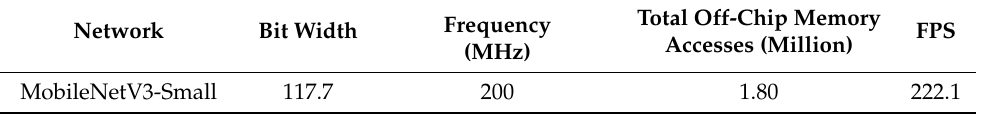
Table 5. Evaluation result for